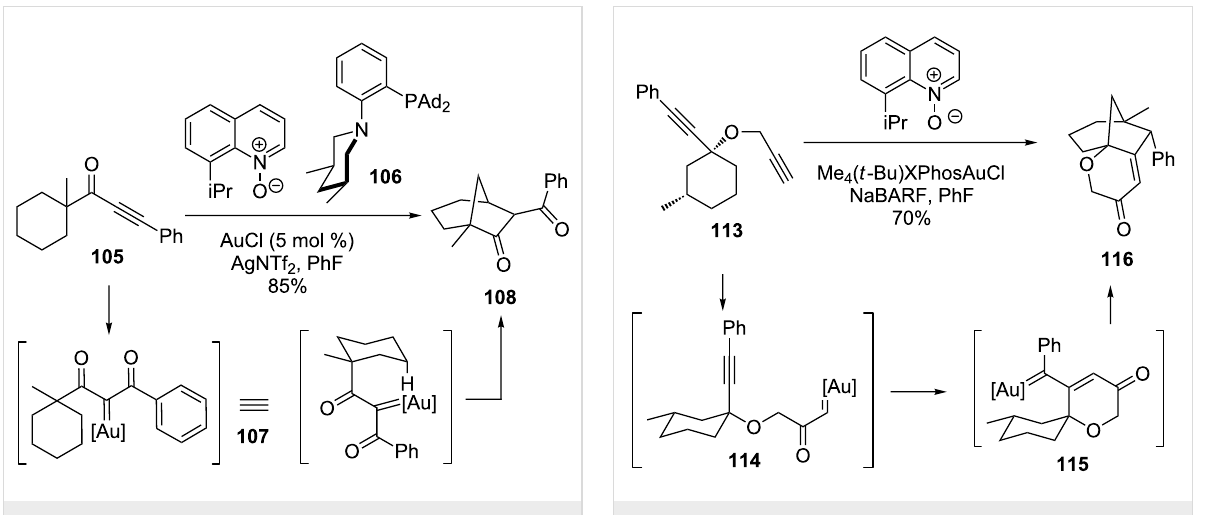
Scheme 23: Au-catalyzed bridged-bicycle